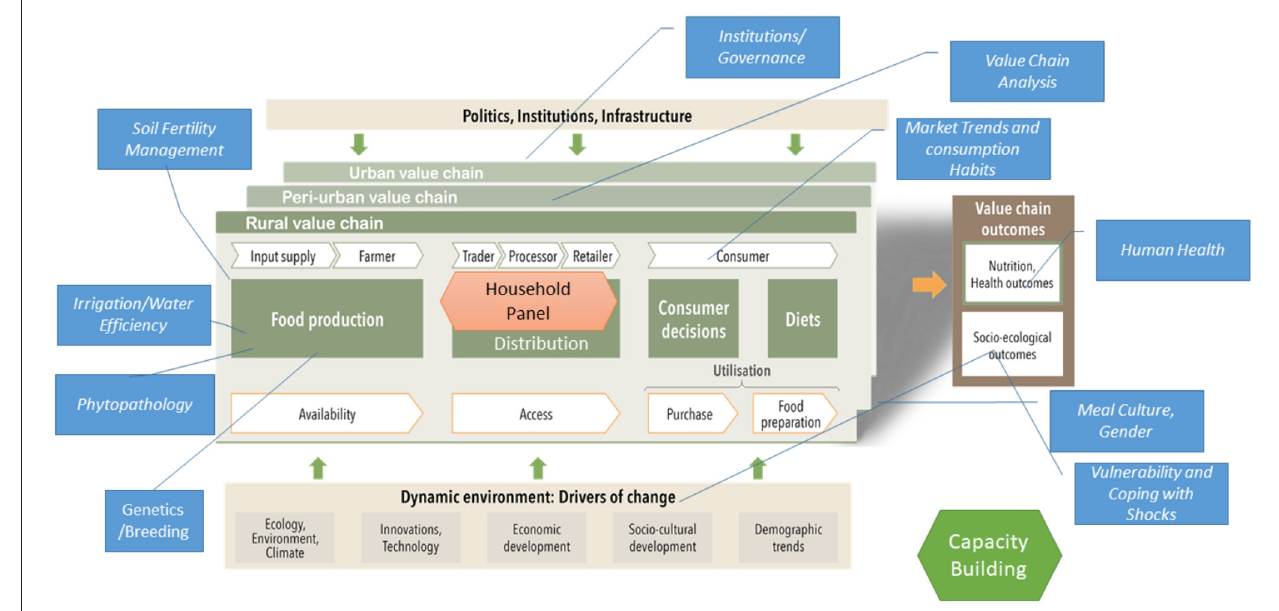
FIGURE 1 | The Value Chain for Food and Nutrition-framework and Disciplines Involved in the Project